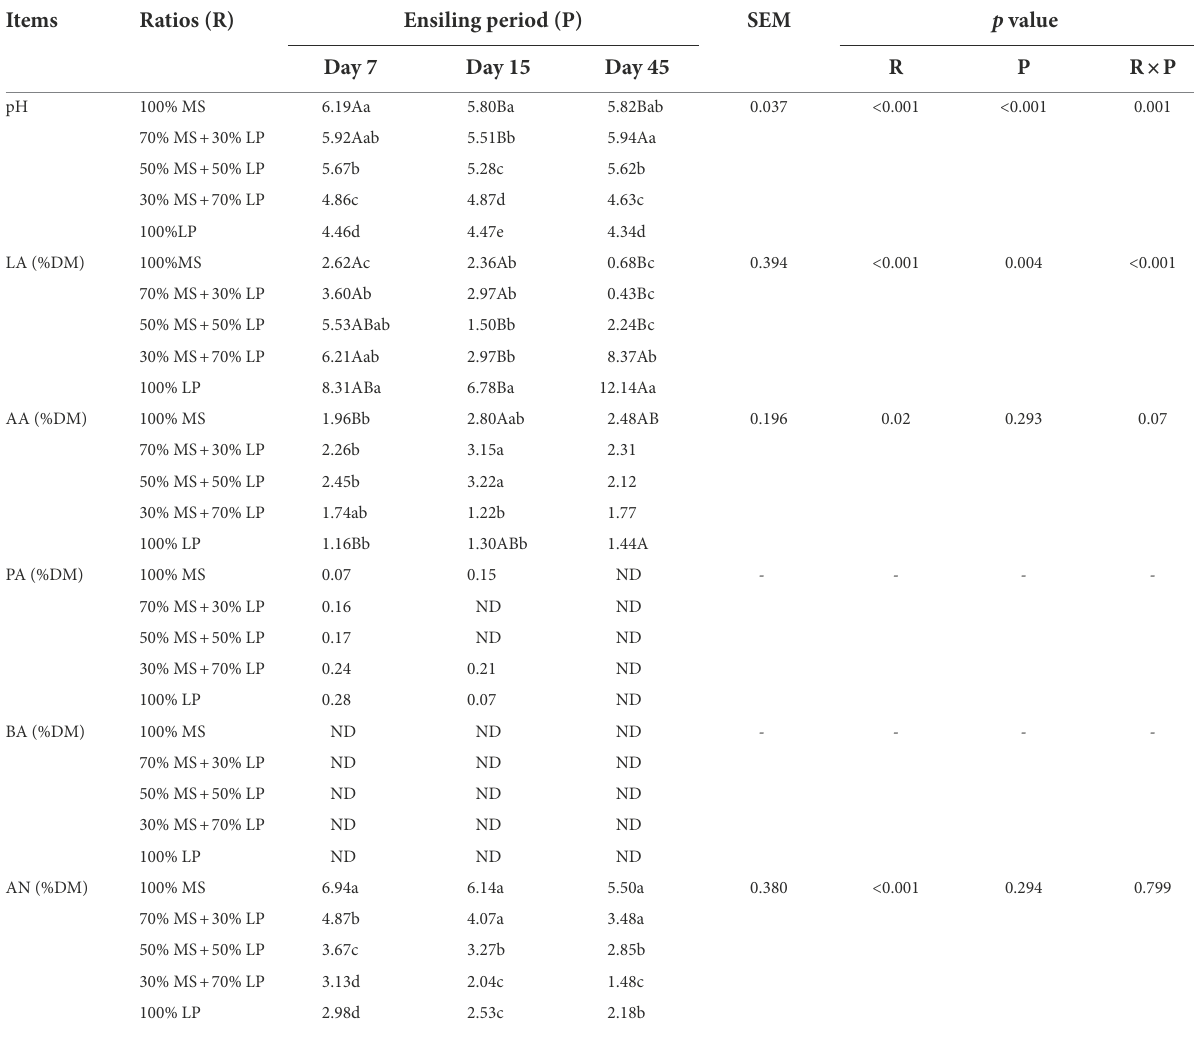
TABLE 3 Dynamic changes in the fermentation quality of perennial ryegrass and alfalfa mixed silage.